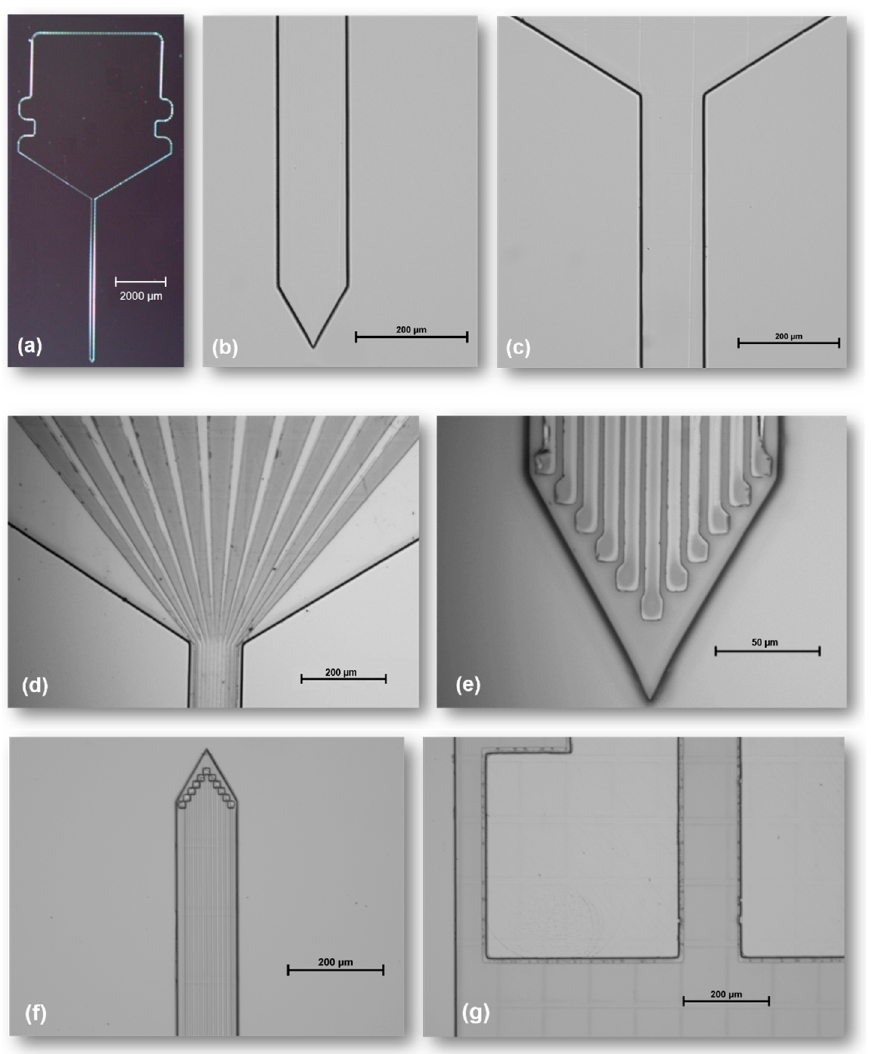
Figure 3. Fabricated neural probe: ( a – c ) patterning of the neural probe geometry; ( d , e ) patterning of the contact pads, tracks and microelectrodes; ( f , g ) passivation of the neural probe, leaving the microelectrodes and contact pads exposed.